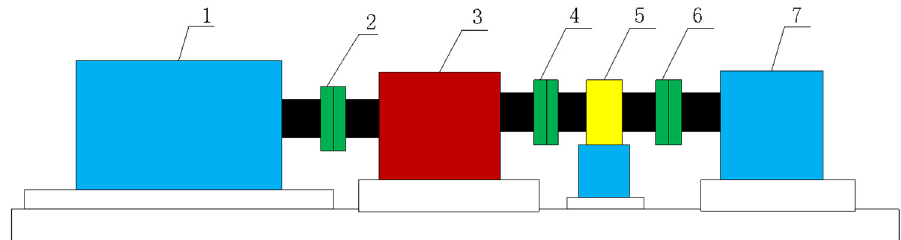
Figure 2. Schematic diagram for the HVD control system. 1. electric motor; 2, 4, 6. flexible coupling; 3. HVC; 5. speed sensor; 7. water pump.